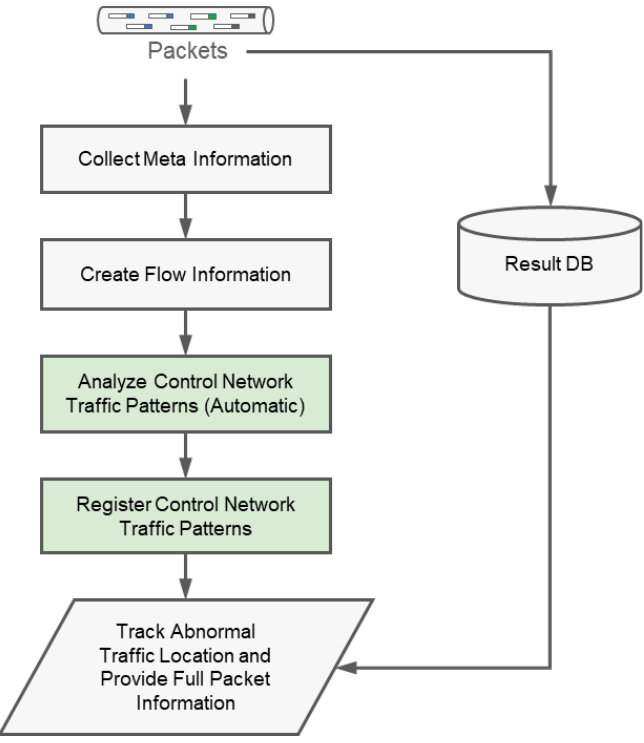
Figure 8. Detection process for the test environment data.